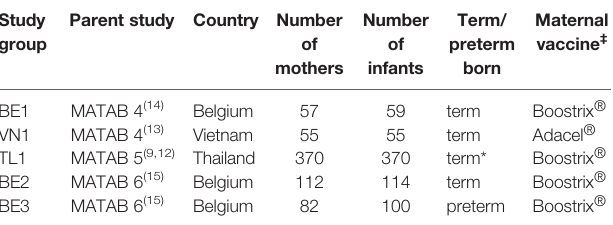
TABLE 1 | Overview of the study groups (BE1: Belgium 1; VN1: Vietnam 1; TL1: Thailand 1; BE2: Belgium 2; BE3: Belgium